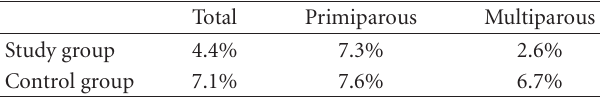
Table 2: Percentage of preterm birth rates plotted on parity status in the study group and control